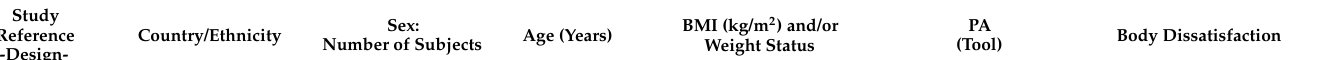
Body Dissatisfaction Figure Rating Scale Main Findings